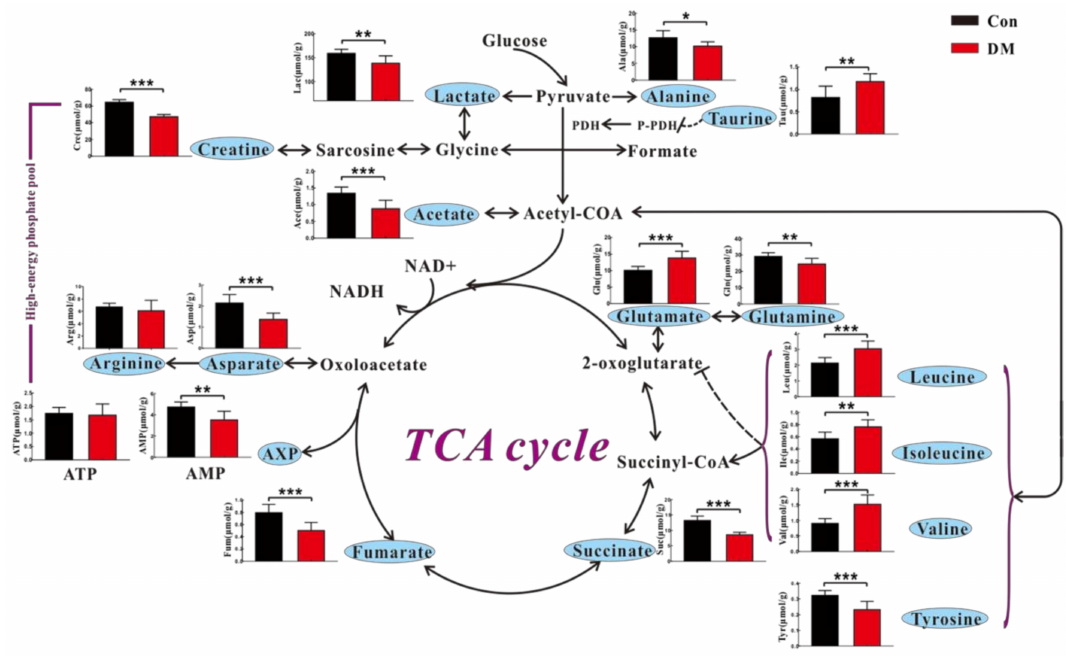
Figure 6. Metabolic changes in the heart of STZ-induced diabetic (DM) and normal control (Con) rats: Data were expressed as Means ± SE ( n = 6); r.u., relative unit; significant level: * p < 0.5; ** p < 0.01; *** p <